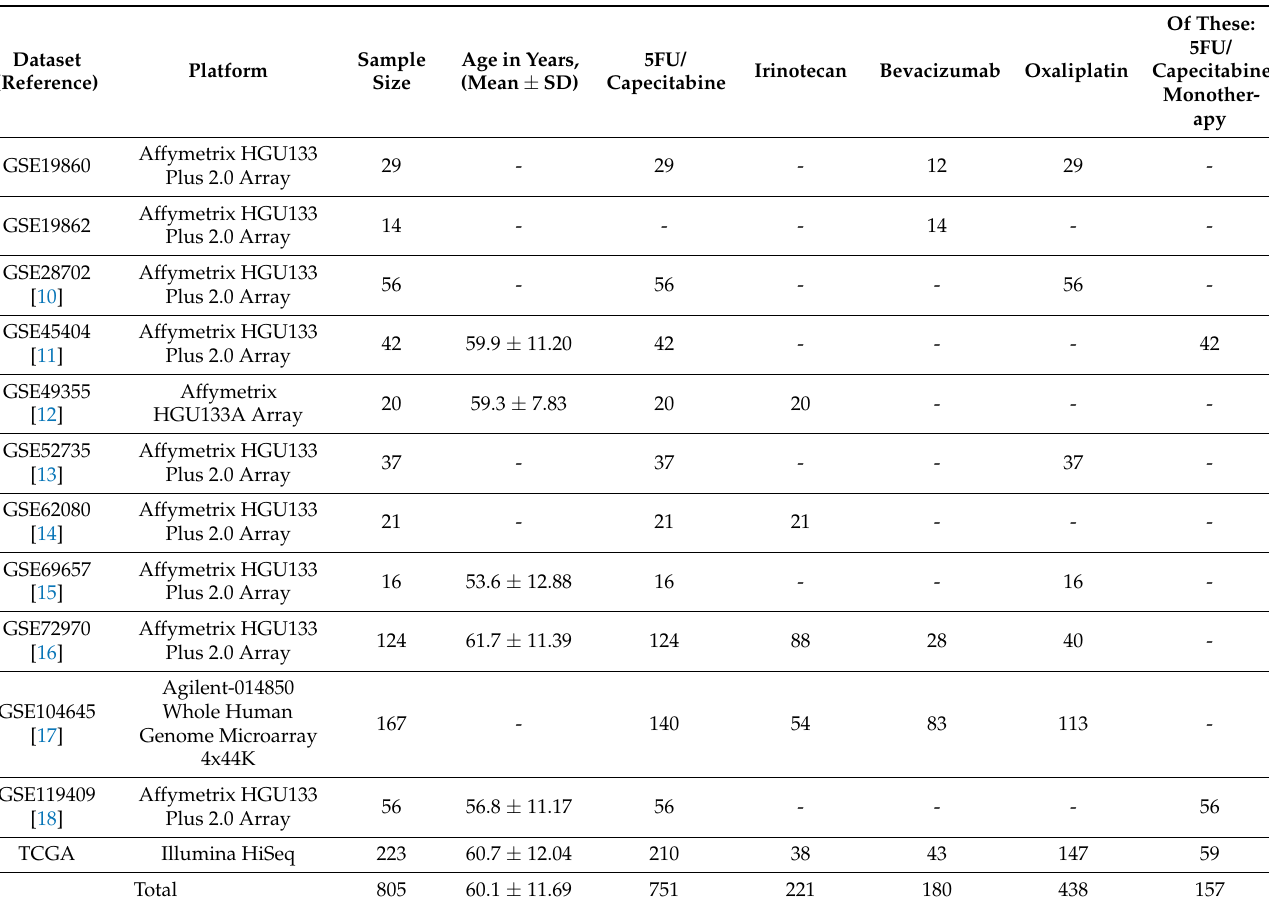
Table 3. Overview of datasets screened for the clinical